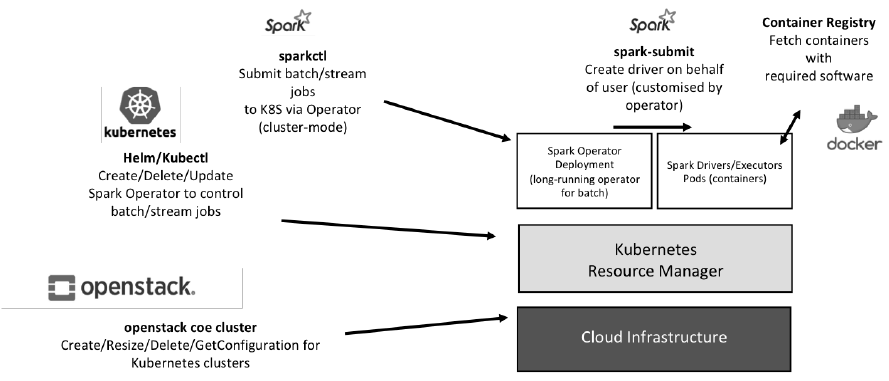
Figure 8: Client tools to manage Spark Kubernetes